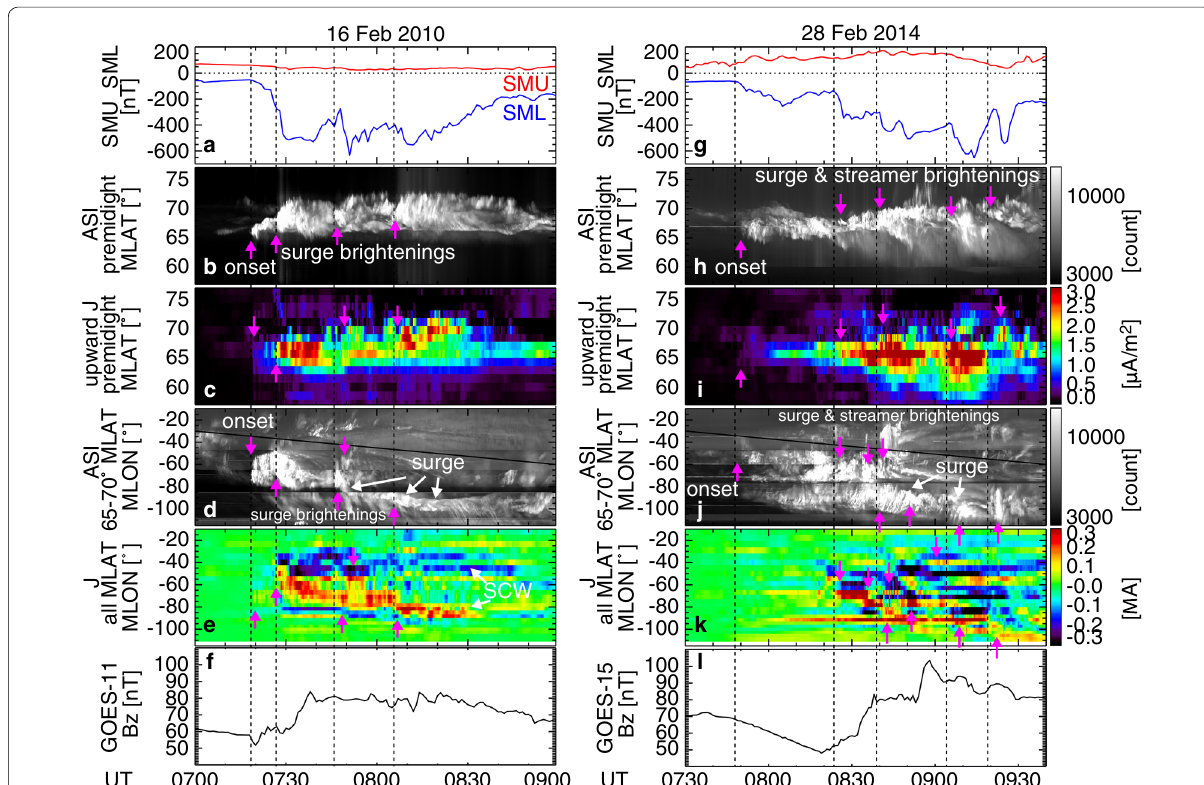
Fig. 1 SMU / SML indices, ASI north–south keogram at pre-midnight, maximum upward current north–south keogram at each latitude at pre-midnight, ASI east–west keogram at 65°–70° MLAT, current east–west keogram integrated over latitude, and GOES magnetic field. a – f and g – l are for the 16 February 2010 and 28 February 2014 substorms. GOES-11 and 15 are about 70° MLON and reach midnight at 9 UT. The dashed lines − and pink arrows highlight auroral and current enhancements. The solid line in Panels d and j marks the magnetic midnight